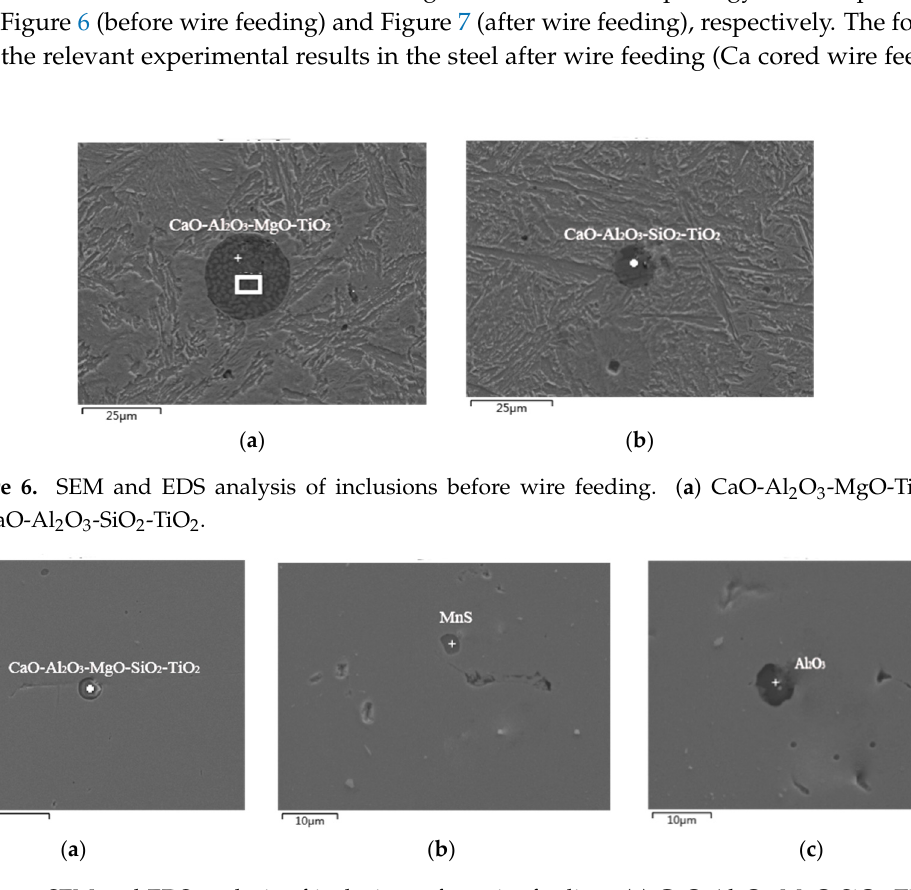
Figure 7. SEM and EDS analysis of inclusions after wire feeding. ( a ) CaO-Al 2 O 3 -MgO-SiO 2 -TiO 2 ; ( b ) MnS; ( c ) Al 2 O 3 .